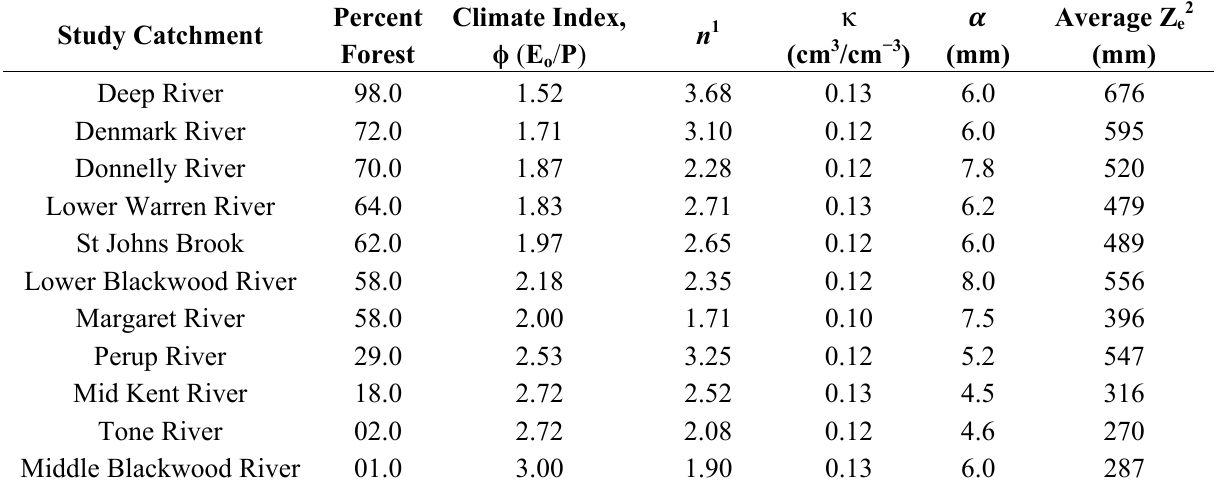
Table 2. Physical and model parameters for the study